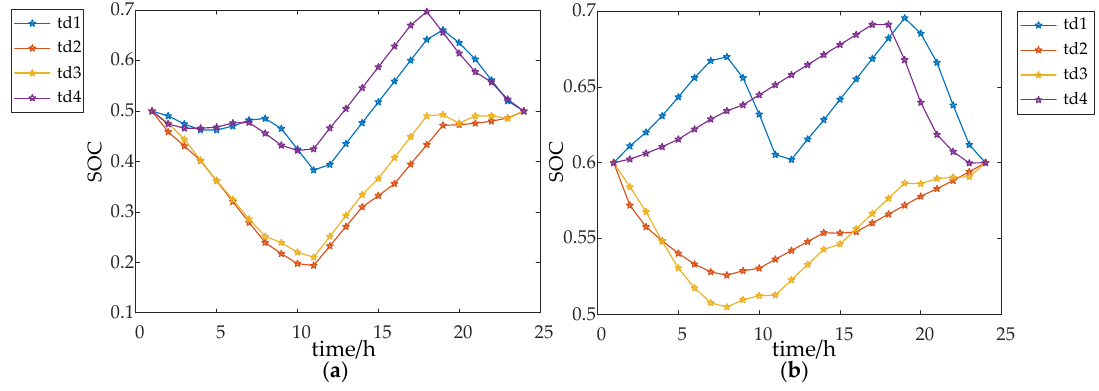
Figure 16. The state of charge on four typical days in 2030 and 2050. ( a ) 2030; ( b ) 2050.